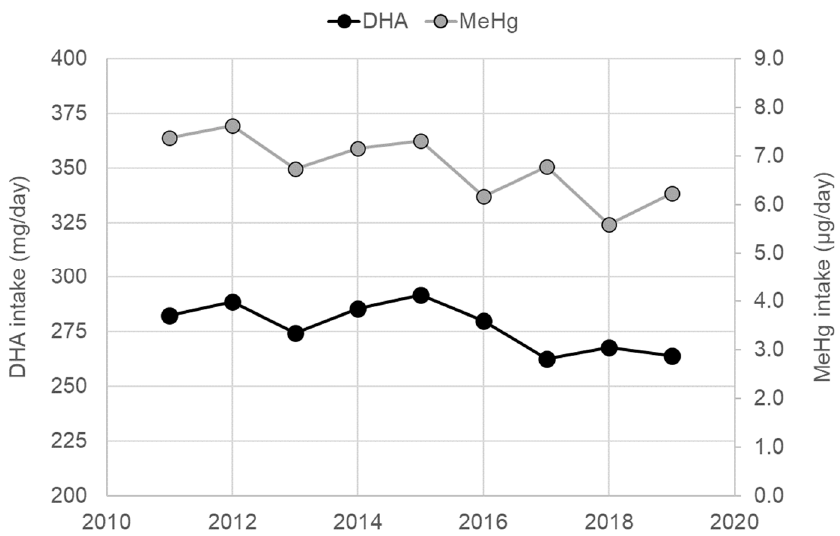
Figure 1. Temporal trend of estimated daily intake of DHA and methylmercury from seafood of Japanese women of childbearing age (20–39 yrs old).